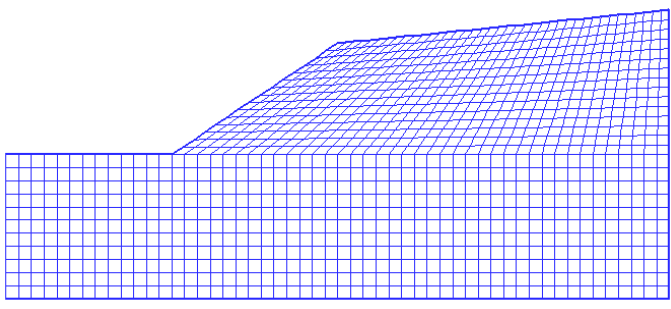
Figure 9. The finite element mesh. Table 2. Parameters of the soil.